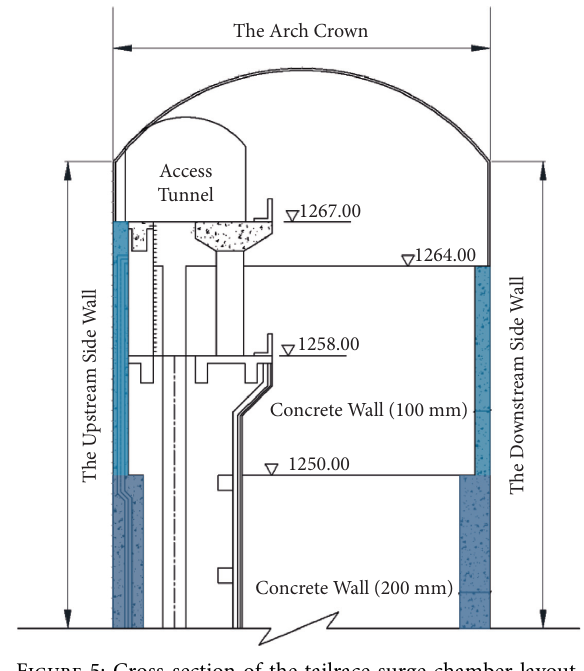
Figure 5: Cross-section of the tailrace surge chamber layout.